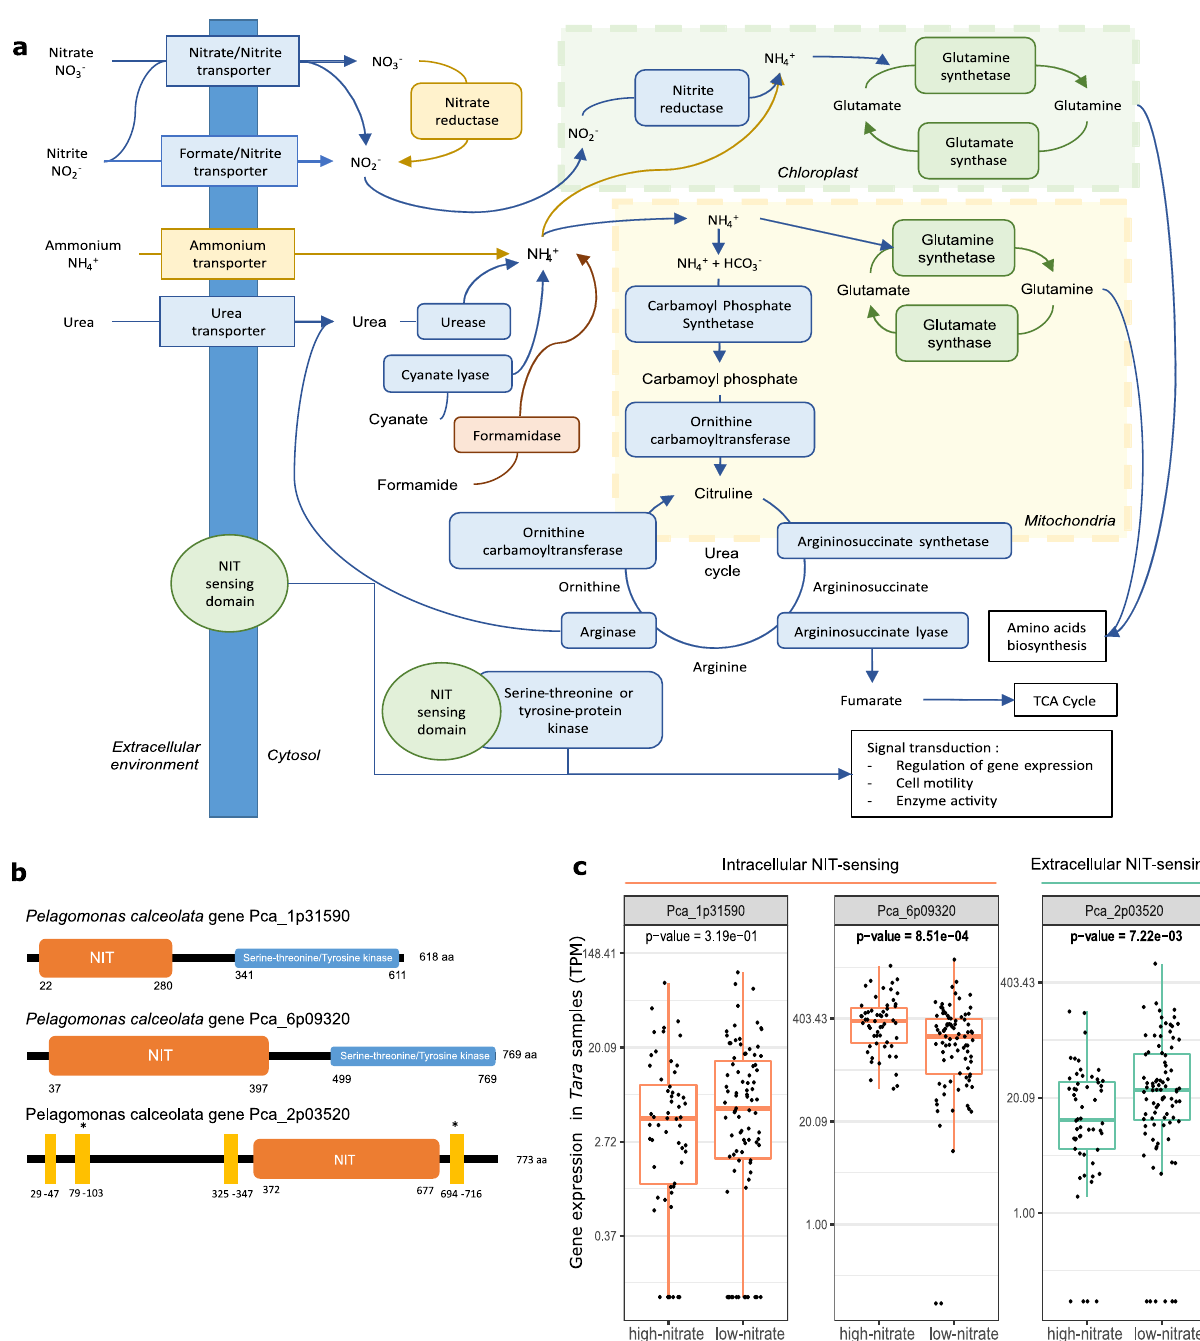
Fig. 5 Nitrogen sensing and metabolism in P. calceolata . a Schematic representation of N transport and assimilation in P. calceolata based on the gene content. The color code indicates if the number of gene copies for a speci fi c function is overrepresented (green), equally represented (blue), underrepresented (orange) or absent (red) in P. calceolata genome compared to the mean of eight pico-nano photosynthetic eukaryotes. Gene copy number for each function is indicated in Supplementary Data 9. b Domain organization of NIT-sensing proteins in P. calceolata . Orange boxes are NIT- sensing domains (IPR13587), blue boxes are serine – threonine/tyrosine-kinase domain (IPR20635), and yellow rectangles are transmembrane domains. c Relative expression levels (TPM) of three NIT-sensing genes in low-nitrate (<2 µ M) and high-nitrate (>2 µ M) environments. P values of Mann – Withney – Wilcoxon tests between low- and high-nitrate samples are indicated for each gene. Signi fi cant P values (<0.01) are in